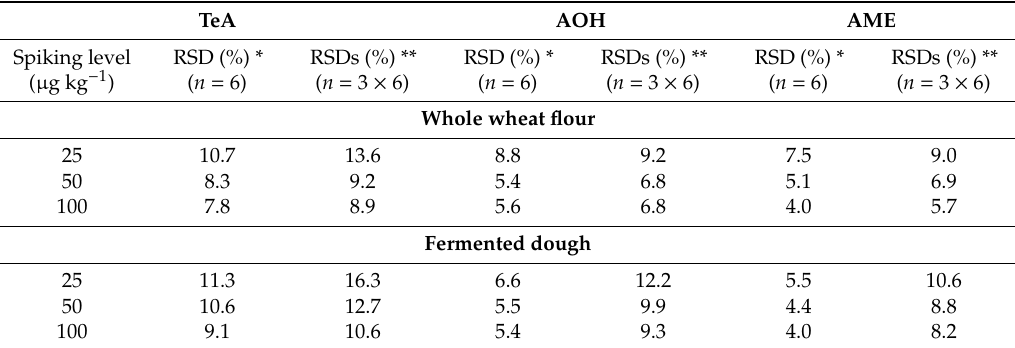
Table 2. Precision parameters of selected Alternaria